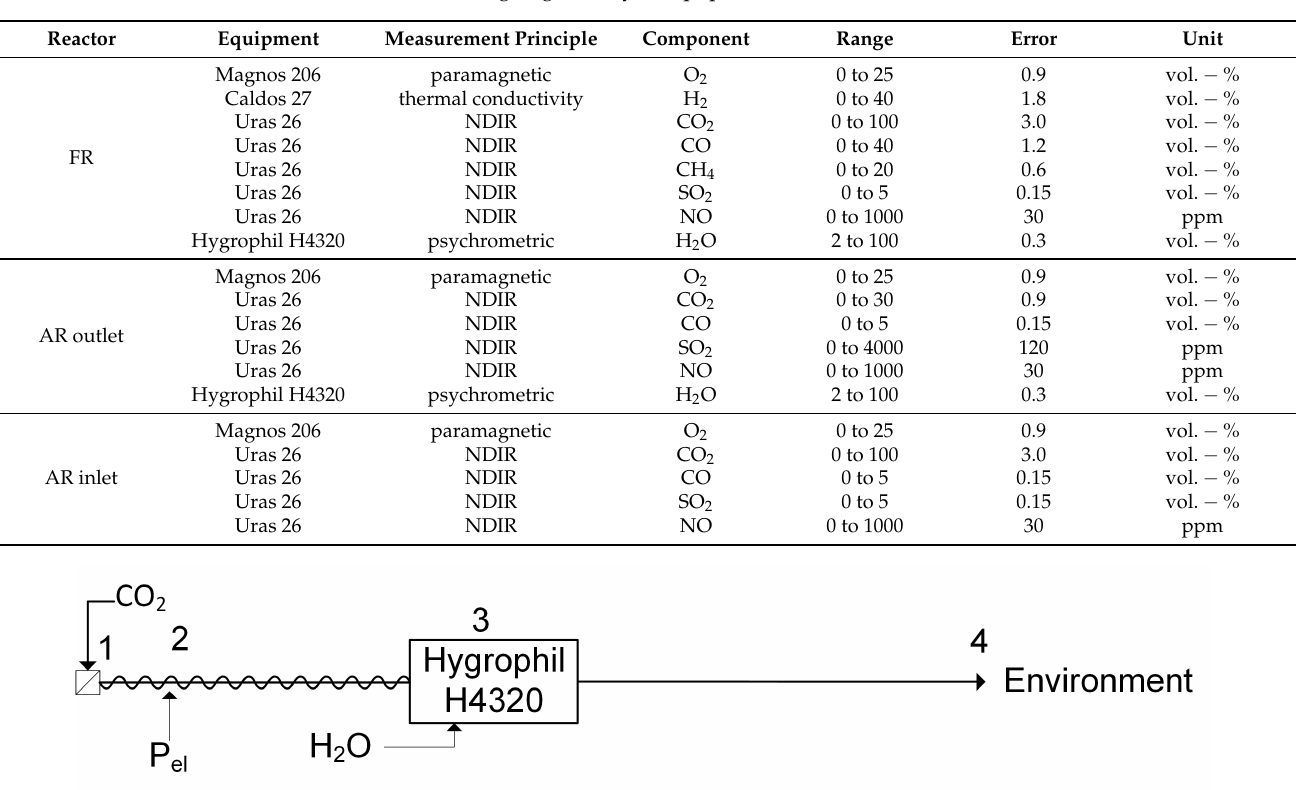
Table 5. Listing of gas analysis equipment for all reactors.